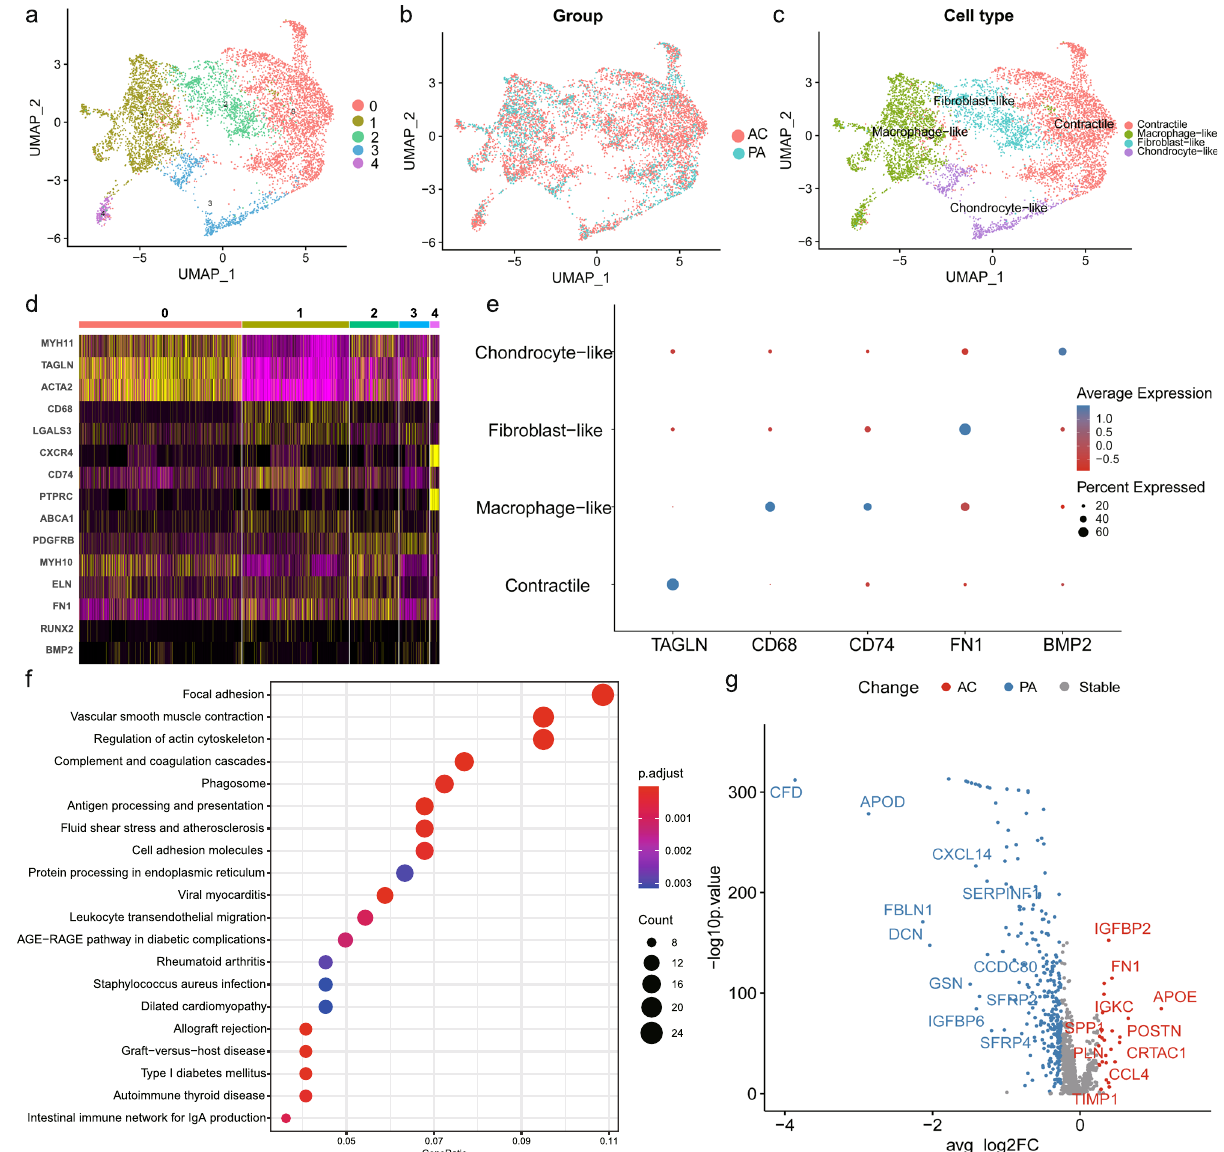
Fig. 2 Diversity of the vascular smooth muscle cells (VSMCs) in proximal adjacent (PA) and calci fi ed atherosclerotic core (AC) portions of plaques. UMAP clustering plots revealing a 5 color-coded cell clusters, b different groups, and c 4 cell population of a total of 7053 individual cells based on gene expression. d . Heatmap of marker genes in different VSMC subsets per among clusters. e Dot plot of cluster-identifying marker genes in VSMCs. f . Top Kyoto Encyclopedia of Genes and Genomes (KEGG) pathways of differently expressed genes (adj. P value < 0.05 and |avg_log2FC|> 0.25) in macrophage- like VSMCs compared with other VSMC subsets. g . Volcano plot shows the differently expressed genes in VSMCs determined that were upregulated in PA or AC group ( P value < 0.01 and |avg_log2FC| >